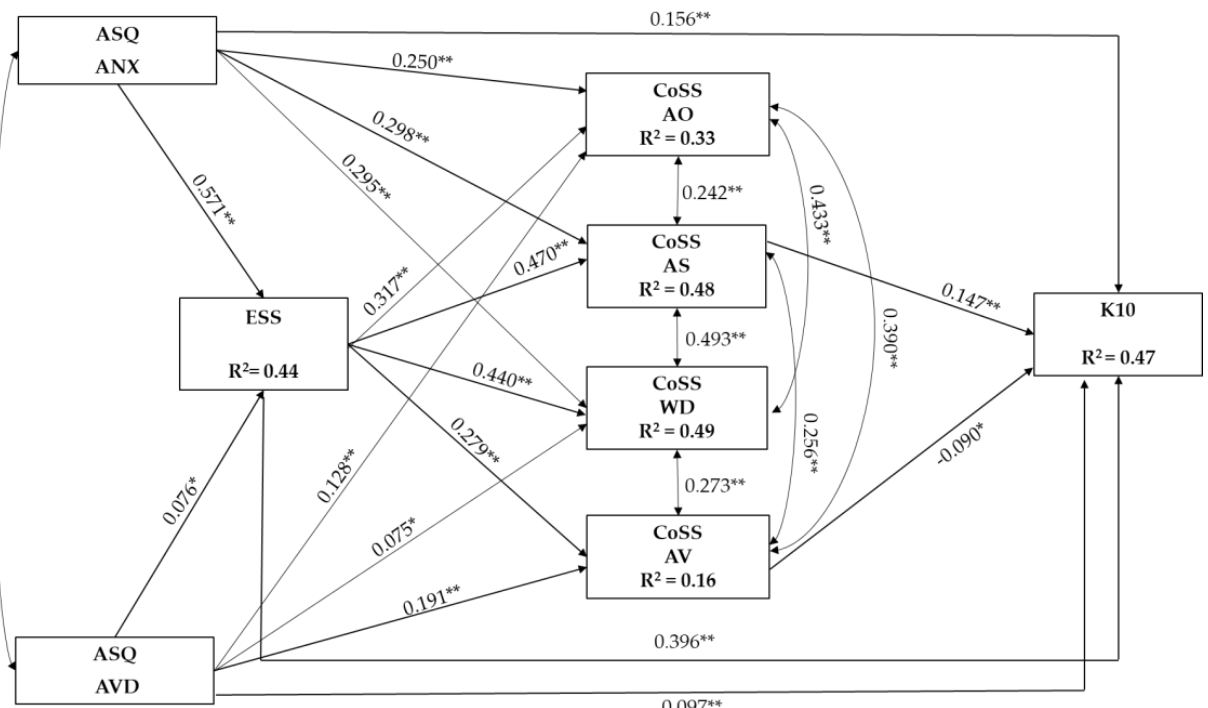
Figure 2. Serial mediation model ( n = 978). Standardized parameter estimates are reported. To ease the interpretation, covariates and non-significant paths/correlations are not shown. ASQ = Attach- ment Style Questionnaire; ANX = attachment anxiety; AVD = attachment avoidance; ESS = Experience of Shame Scale; CoSS = Compass of Shame Scale; AO = attack other; AS = attack self; WD = withdrawal; AV = avoidance; K10 = Kessler psychological distress scale. * p < 0.01. ** p < 0.001.